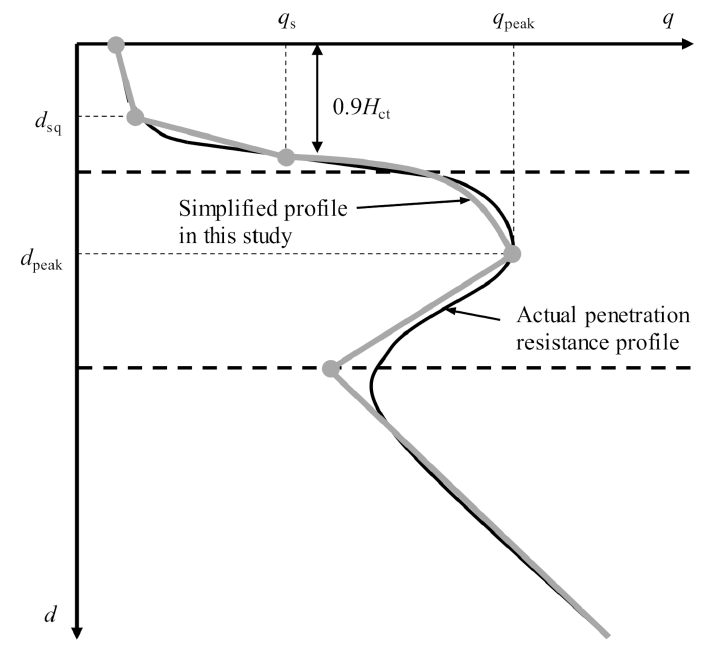
Figure 6. Illustration of simplified squeezing